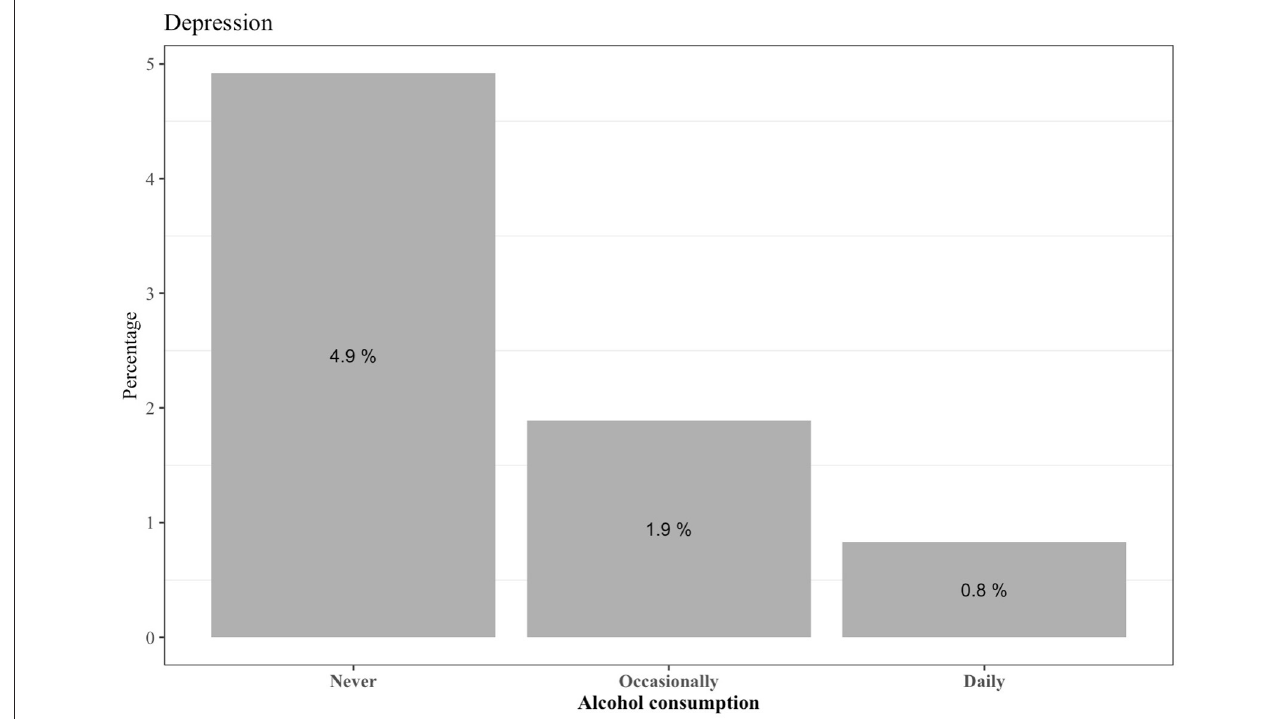
FIGURE 2 | Prevalence of depression symptoms per alcohol consumption levels ( n = 32).